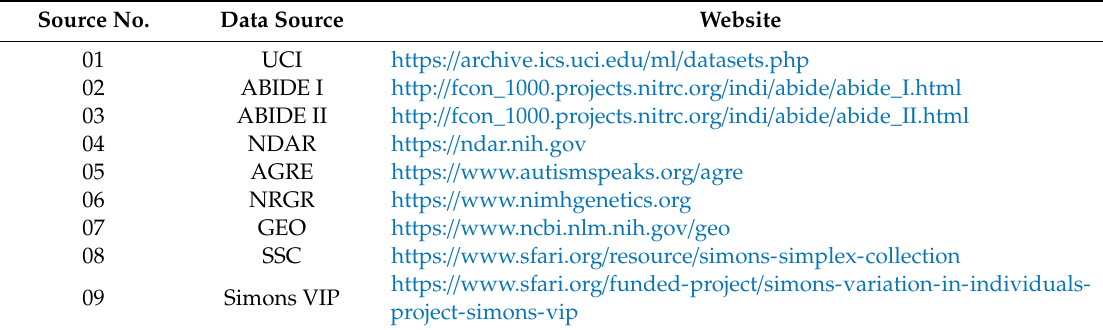
Table 2. Various sources of autism